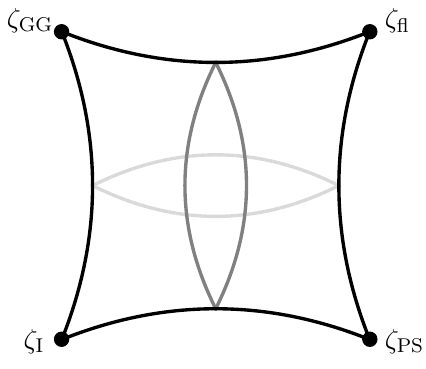
Figure 1 . Orbifold T 2 = Z 2 with two Wilson lines and the (cid:12)xed points (cid:16) I , (cid:16) PS , (cid:16) GG , and (cid:16) (cid:13)